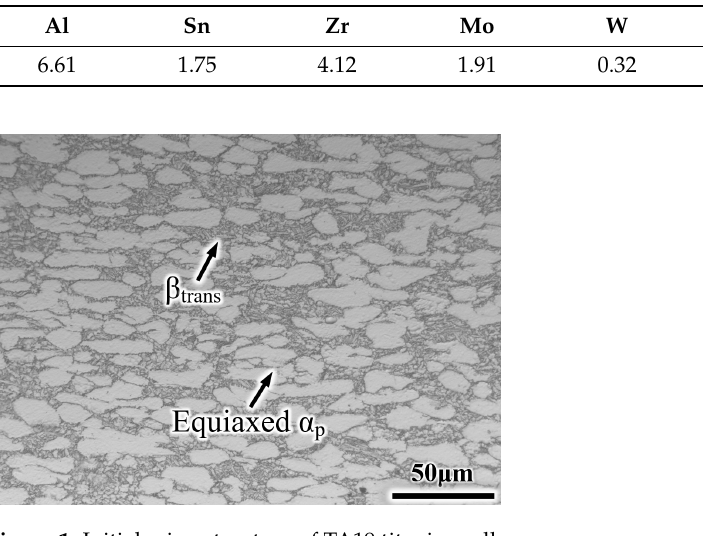
Figure 1. Initial microstructure of TA19 titanium alloy.